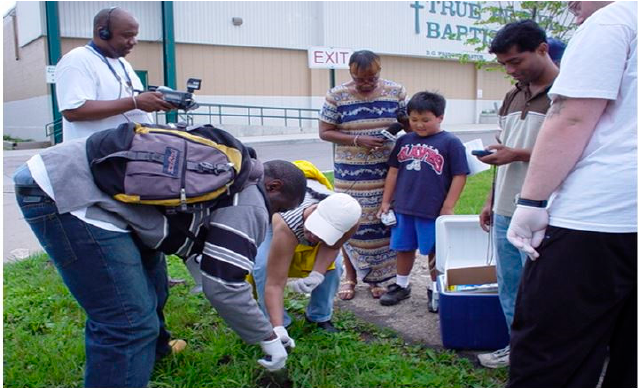
Figure 2. Community members taking soil samples for analysis.